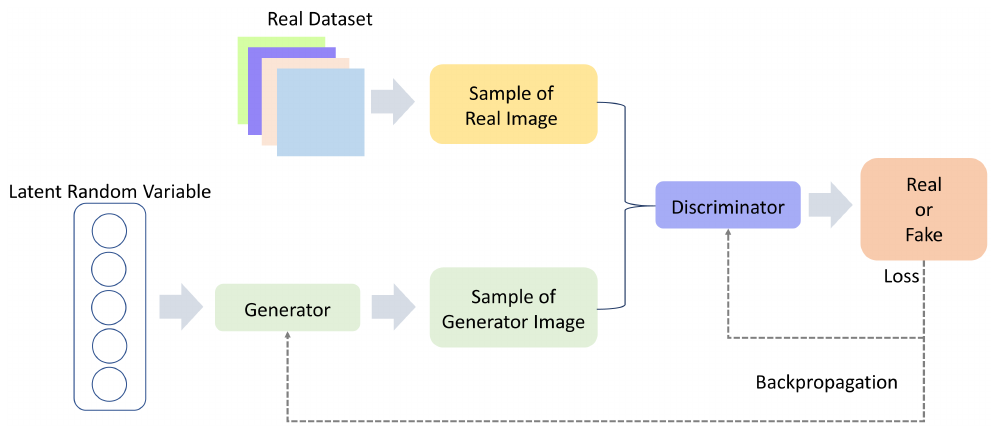
Figure 10. The structure of generative adversarial